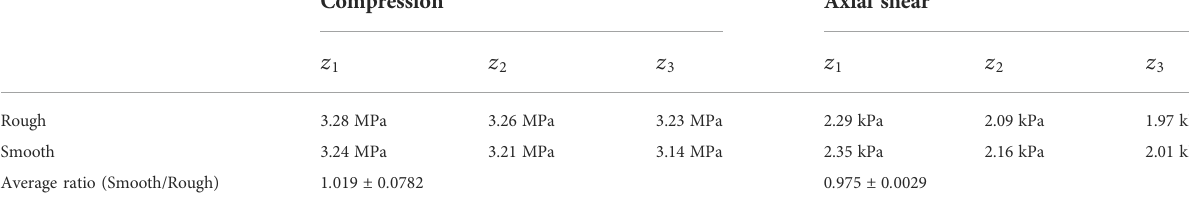
TABLE 1 Maximum values of the monitoring points were calculated by